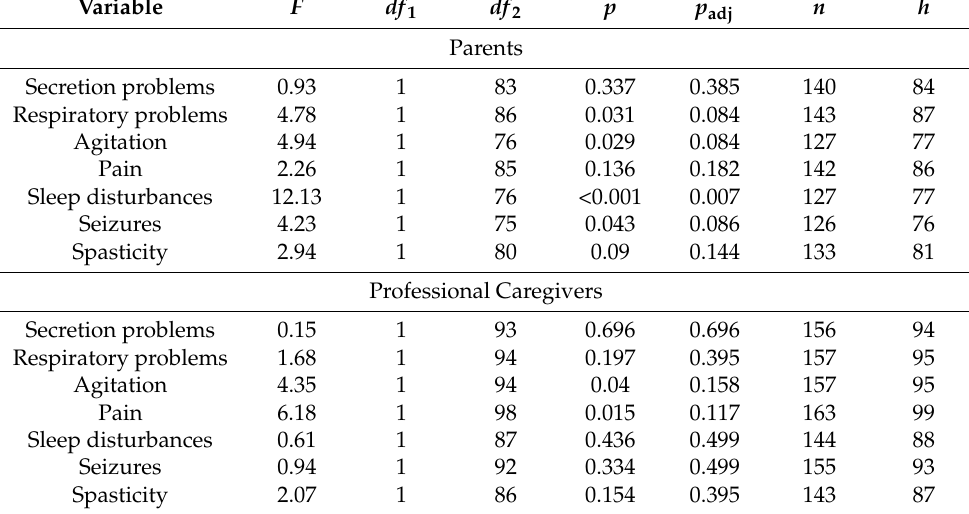
Table 6. Results of the robust